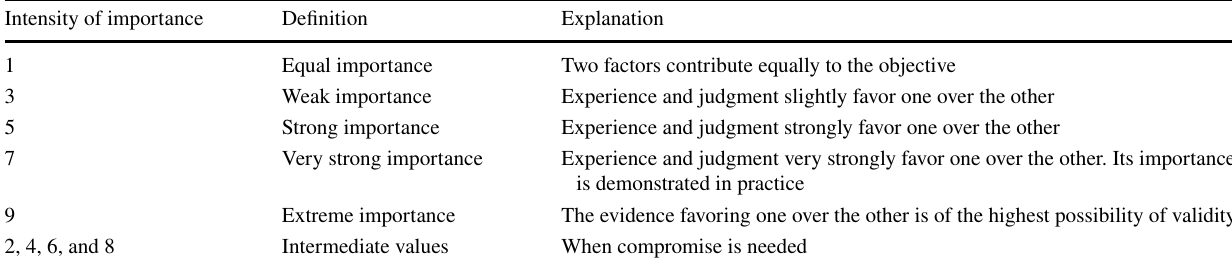
Table 4 Saaty's pairwise scale and its explanation (Congalton